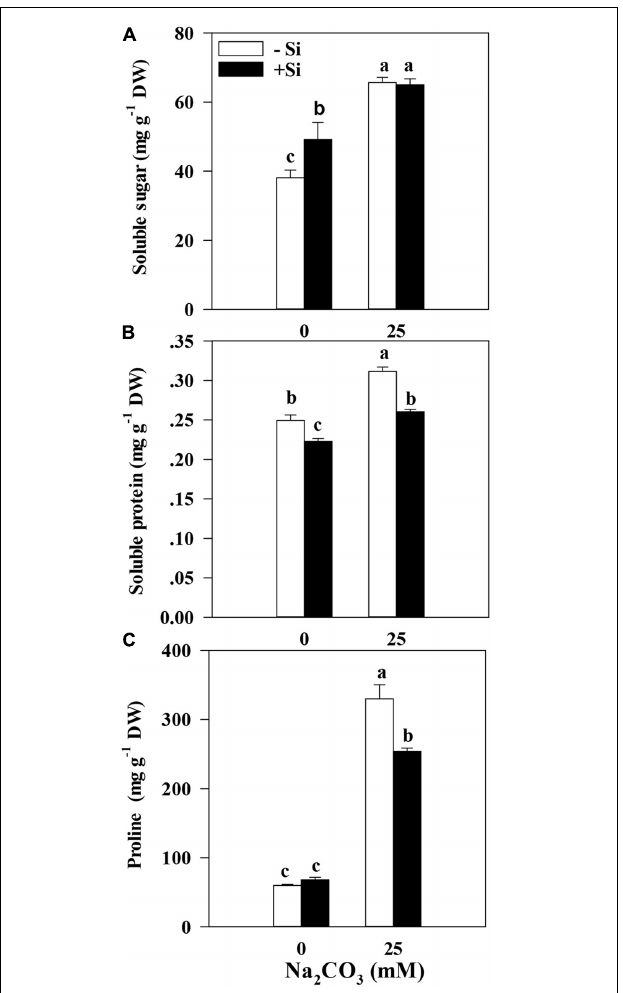
FIGURE 5 | Soluble sugar content (sucrose) (A) , soluble protein content (B) , and proline content (C) in the leaves of alfalfa seedlings under Si priming in response to alkaline stress. –Si = pretreatment without Si; +Si = pretreatment with Si. Values are means ± SE, n = 25. Different letters denote significant difference ( P < 0.05) based on Duncan’s